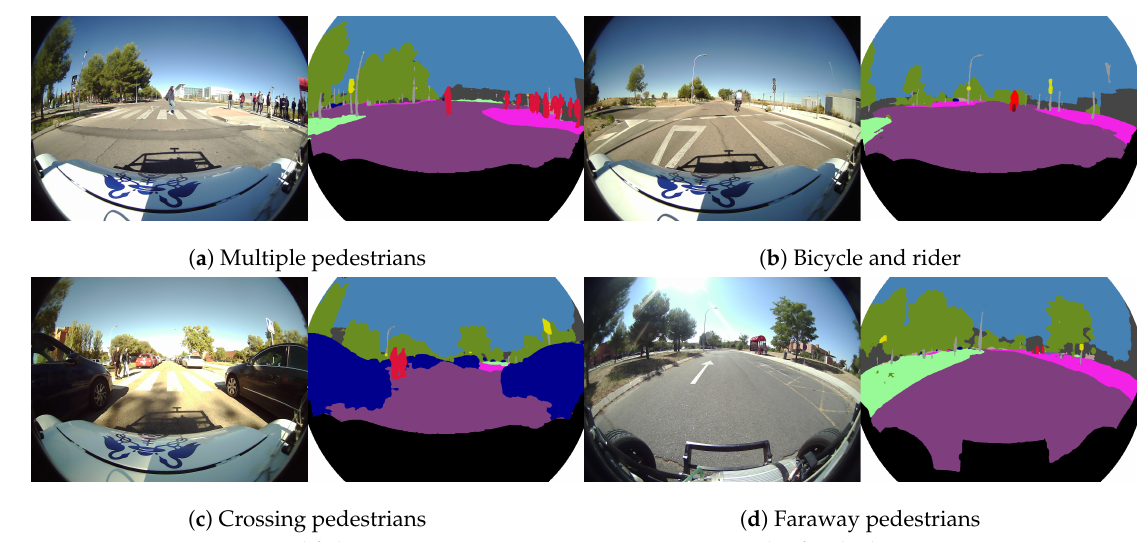
Figure 13. Real fisheye camera semantic segmentation examples for flat group.